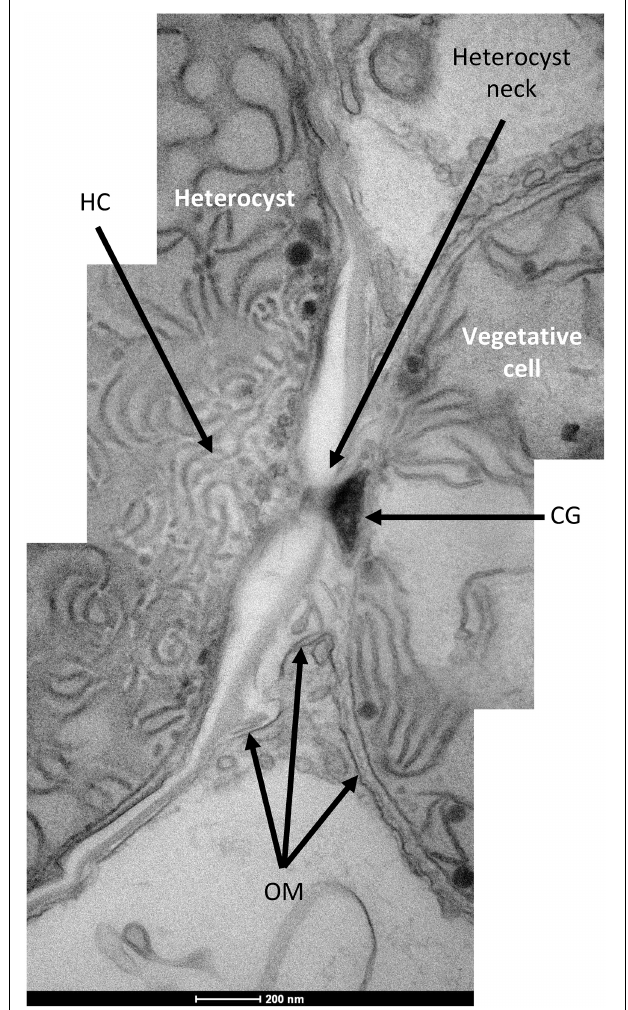
FIGURE 7 | Transmission electron micrograph of the vegetative cell-heterocyst junction in a R. intracellularis filament endosymbiotic in H. hauckii. Note the honeycomb membrane structure (HC), the heterocyst neck, the continuous outer membrane (OM) and the cyanophycin granule